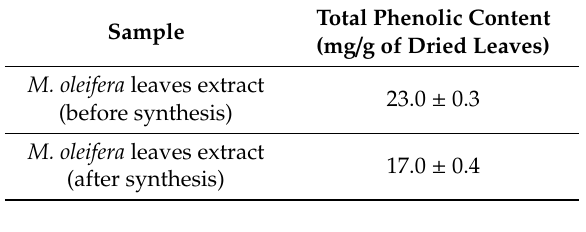
Table 2. Determination of total phenolic content before and after the synthesis of bismuth nanoparticles.